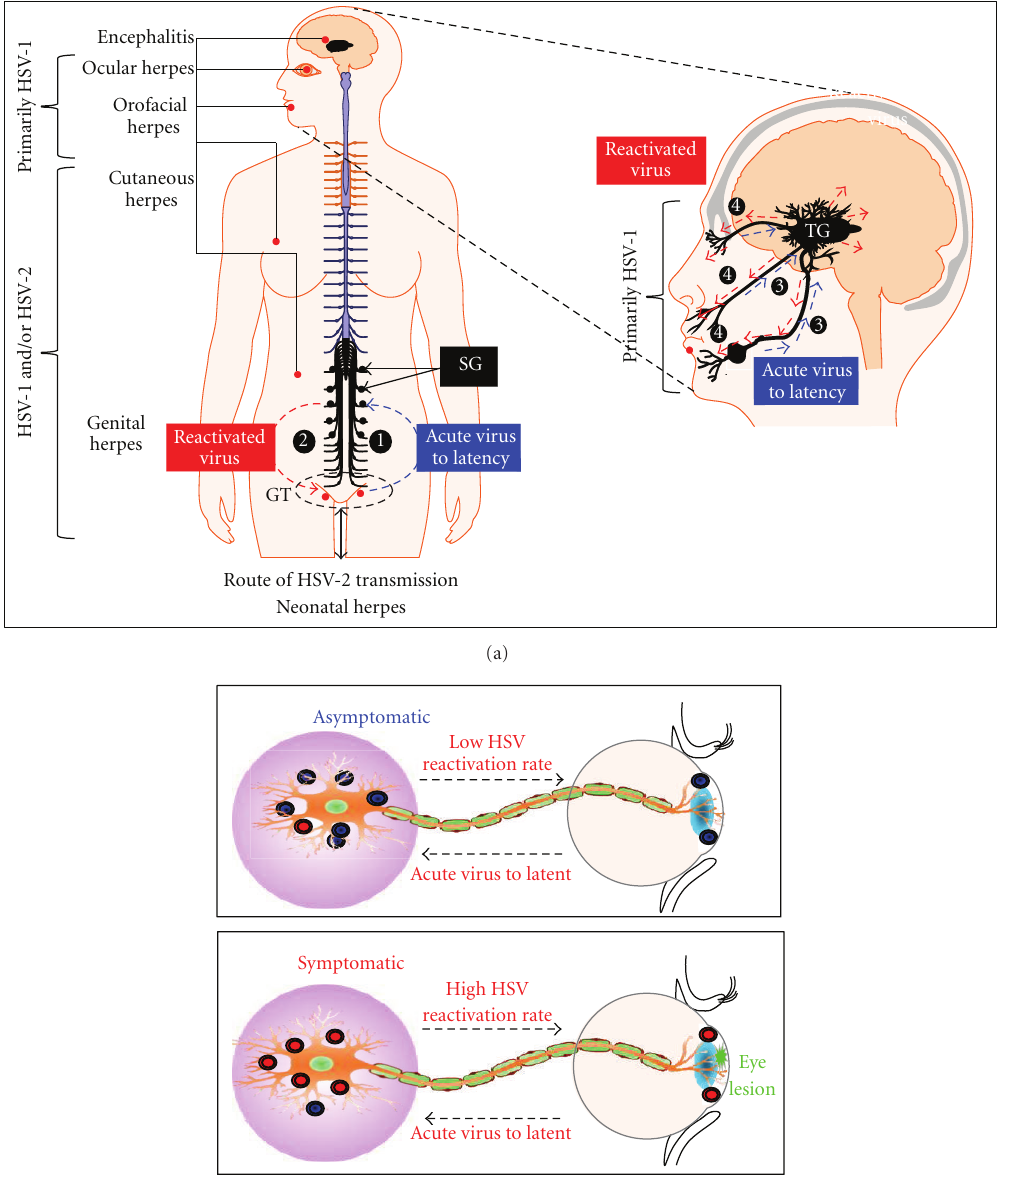
Figure 1: The majority of ocular herpes vaccines are injected parenterally, and although they induced strong systemic immune responses, they failed to generate significant local immune responses either in the eye or in trigeminal ganglia (TG). Local immune responses at these sites are likely needed to prevent virus transmission and to reduce virus replication, which should eventually reduce viral latency/reactivation and limit the severity of ocular herpes. Several results from our lab strongly suggest that there is linear association between presence of “asymptomatic” CD8 + T cells (bleu circles) in the TG and ocular mucosal immune system with the lack of eye disease. In contrast, the absence of asymptomatic CD8 + T cells and presence of symptomatic CD8 + T cells (red circles) may increase the rate of HSV reactivation and pathology. The upper panel shows scenario of an asymptomatic HSV-1 infection and the lower panel shows symptomatic HSV-1 infection and eye